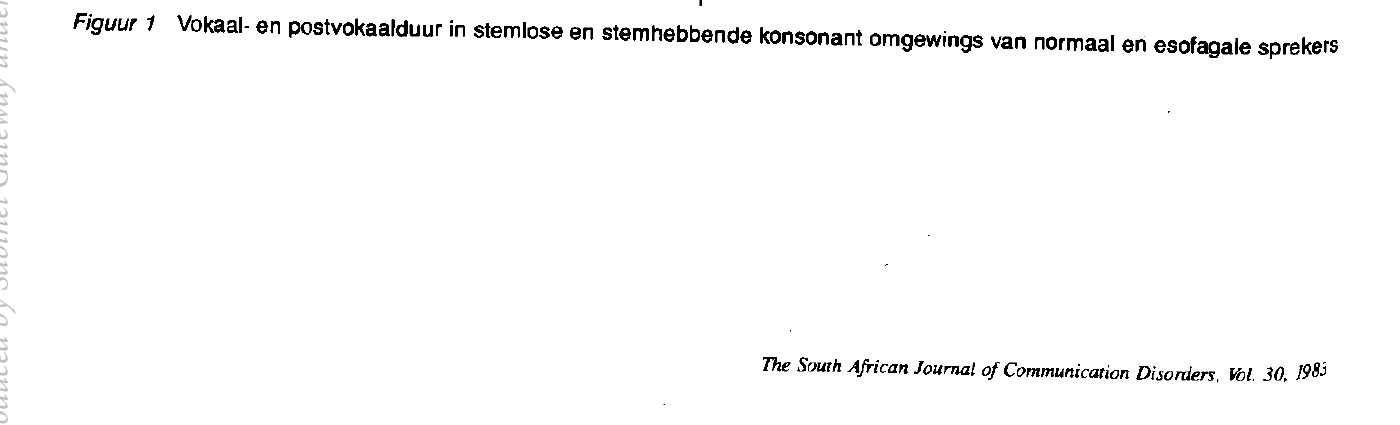
Figuur 1 Vokaal- en postvokaalduur in stemlose en stemhebbende konsonant